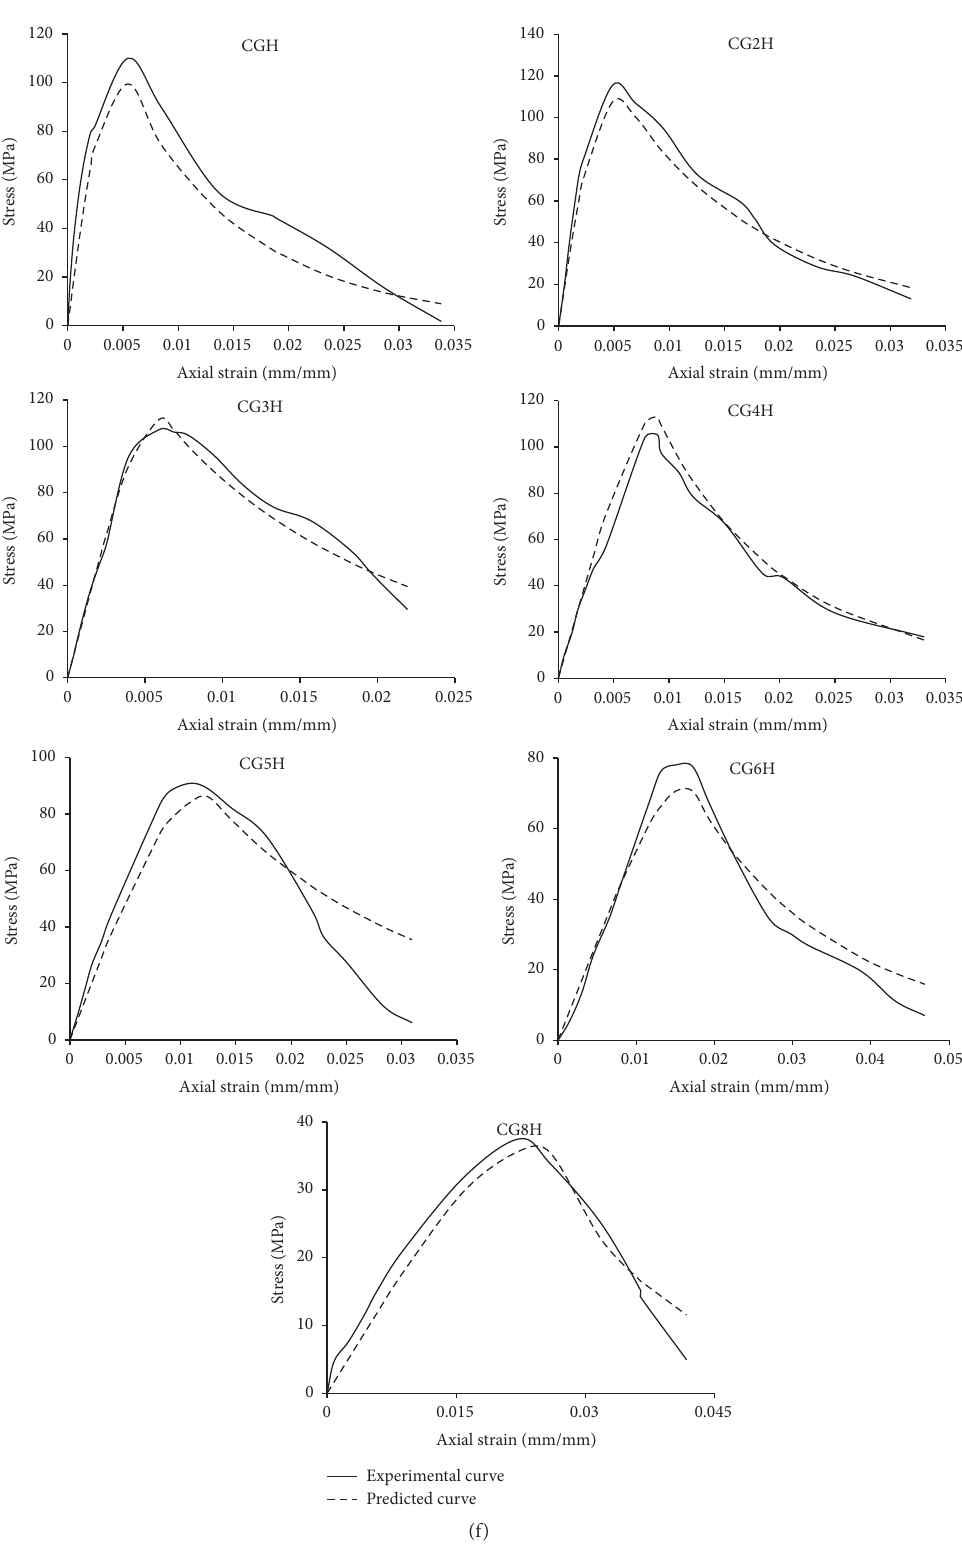
Figure 1: (a) Comparison of experimental and predicted residual stress-strain curves of CBH series specimens. (b) Comparison of experimental and predicted residual stress-strain curves of CCH series specimens. (c) Comparison of experimental and predicted residual stress-strain curves of CDH series specimens. (d) Comparison of experimental and predicted residual stress-strain curves of CEH series specimens. (e) Comparison of experimental and predicted residual stress-strain curves of CFH series specimens. (f) Comparison of experimental and predicted residual stress-strain curves of CGH series